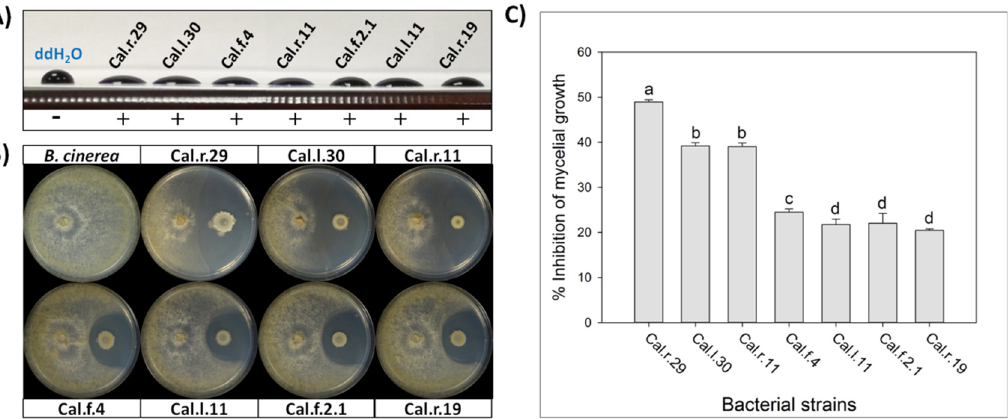
Figure 1. ( A ) Detection of secreted biosurfactants in the cell free supernatant of the seven studied bacterial strains using drop collapse assay. ( B ) Direct antifungal activity of endophytic Bacillus strains against B. cinerea by an in vitro dual culture assay. ( C ) Percentage of inhibition of mycelial growth (IMG) after each bacterial formulation against B. cinerea in vitro. Data values represent the mean of 4 biological replicates ± SD. Letters indicate the statistical difference between treatments after Tukey analysis ( p < 0.05).